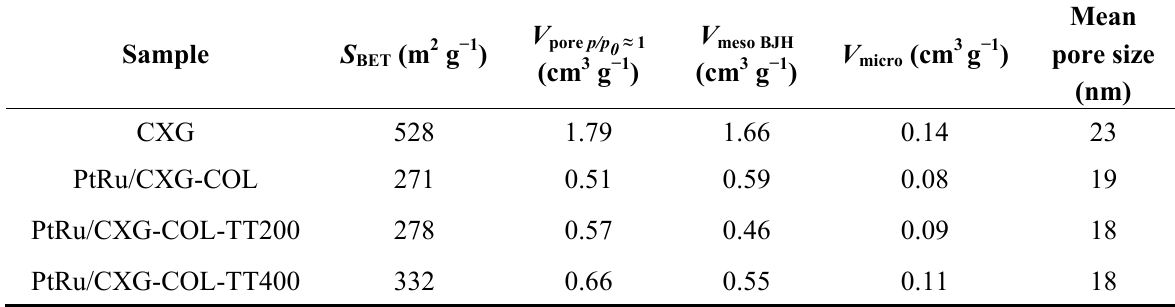
Table 1. Brunauer-Emmet-Teller (BET) surface area and pore volumes obtained from N adsorption isotherms for the carbon xerogel and the PtRu-catalysts prepared.